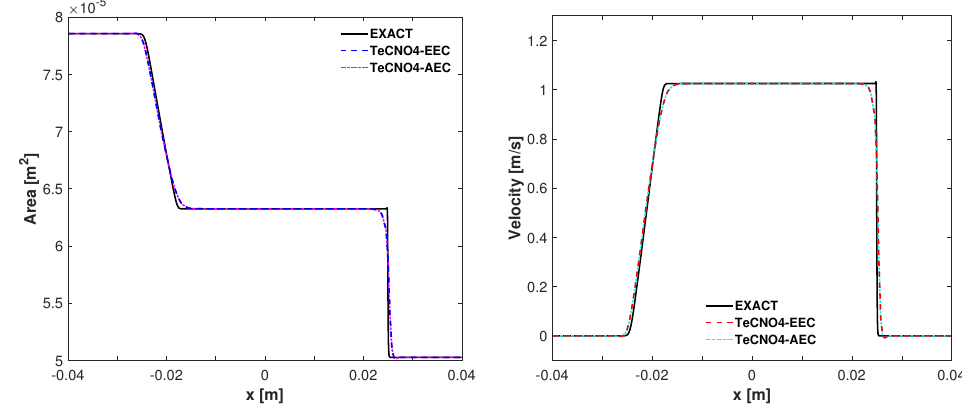
Figure 1. Example-1: Numerical solutions of the ideal tourniquet problem at t = 0.005 s on a mesh with 200 cells: area ( left ) and velocity ( right